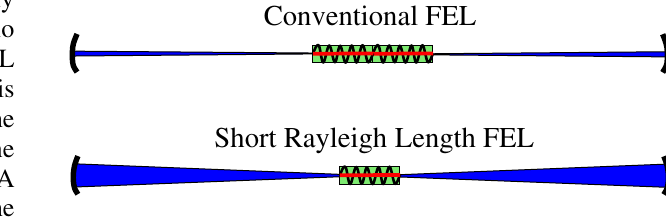
FIG. 1. (Color) Schematic comparison of the conventional and short-Rayleigh length FEL